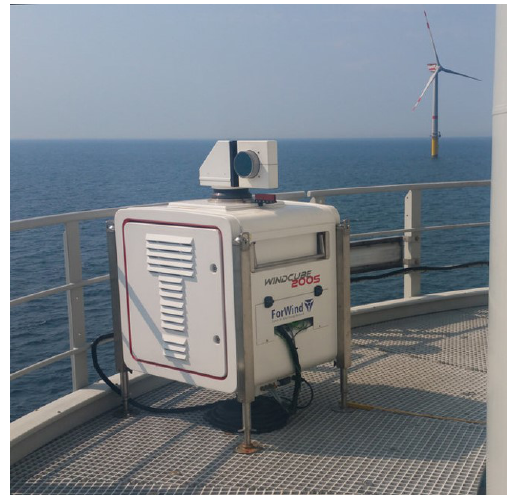
Figure 7. Image of the WindCube200S installed on the transition piece of the wind turbine in the offshore wind farm Global Tech I. Picture taken by Stephan